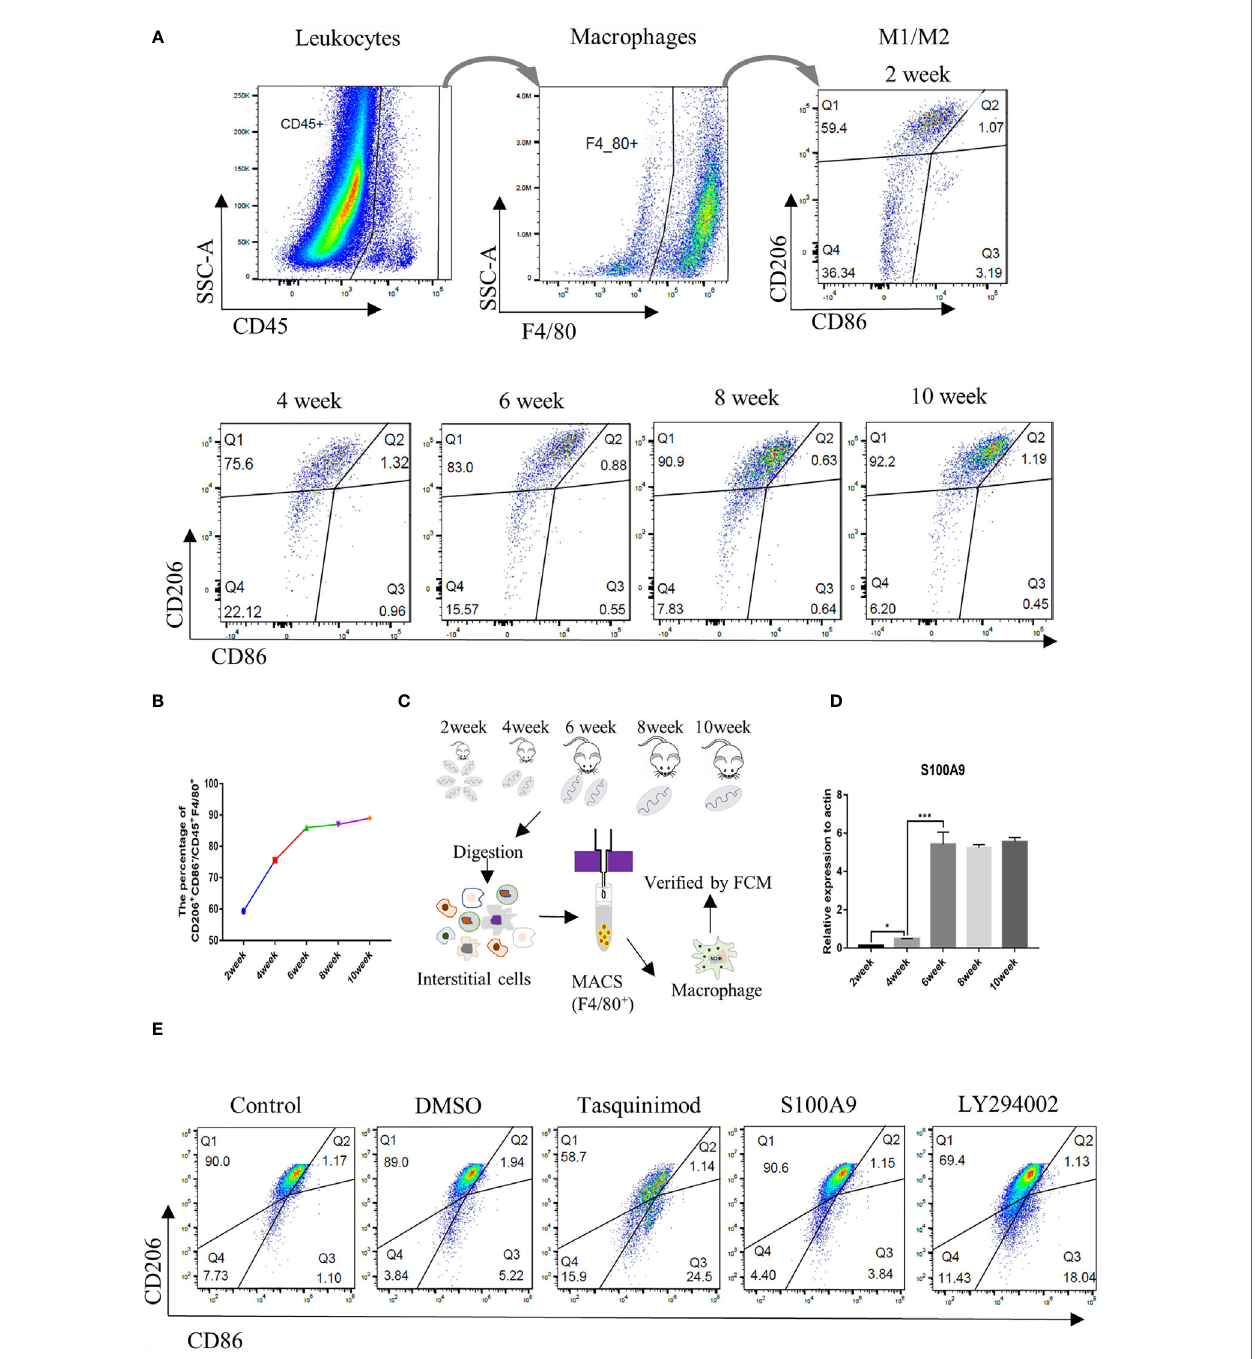
FIGURE 2 | Ratio of M2 TMs and S100A9 mRNA expression increases with the development of mouse testis. (A) Gating strategy that describes CD45 + F4/80 + mouse testis fraction and the distinction of M2 (CD206 + CD86 - ) and M1 (CD206 - CD86 + ) population, represented by Q1 and Q3 respectively (2week, n =4/group; 4- 6week, n =3/group; 8-10week, n =2/group). (B) Percentage of M2 F in different age of TMs by FCM. (C) Flow chart of preparation for TMs, testes from weeks 2 to 10 were digested and interstitial cells were incubated with F4/80 magnetic beads (2week, n =8/group; 4-6week, n =6/group; 8-10week, n =4/group). TMs were obtained by magnetic cell sorting (MACS), and the purity was veri fi ed by fl ow cytometry for subsequent experiment. (D) Relative mRNA expression of S100A9 at different ages of TM (2week, n =6/group; 4-6week, n =5/group; 8-10week, n =4/group). (E) Percentage of M2 F in adult mouse testis (8week, n =2/group) under physiological conditions decreased with the treatment of S100A9 inhibitor (tasquinimod) or PI3K inhibitor (LY294002), compared with the control group. DMSO and S100A9 groups were used as control. Data represent the mean ± standard error (n=2-3). Signi fi cant differences between the two groups are indicated as *P < 0.05, ***P < 0.001; comparisons between groups using one-way ANOVA followed by Dunnett ’ s multiple comparisons